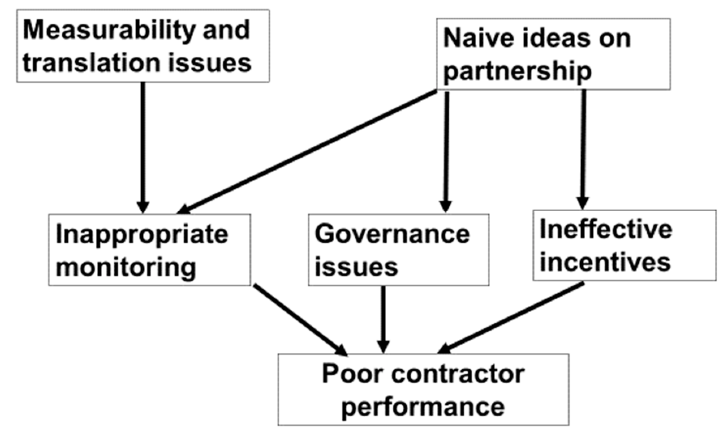
Figure 1. Related issues surrounding PBC for road maintenance in the Netherlands.